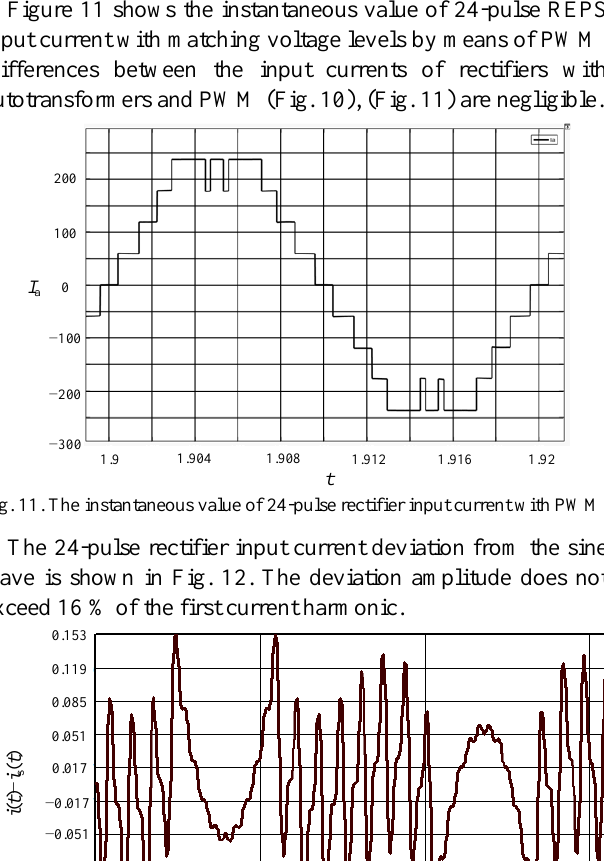
Fig. 9. Dependence of THD of the input current of 24-pulse rectifier on the values of shift angles  i : a) 3D chart; b) cross section in the horizontal plane. To design and operate systems with multi-pulse rectifiers, except THD, the maximum rectifier input current deviation from a sine wave (the vector sum of the highest harmonics in a controlled range of frequencies) is important. Knowledge of the